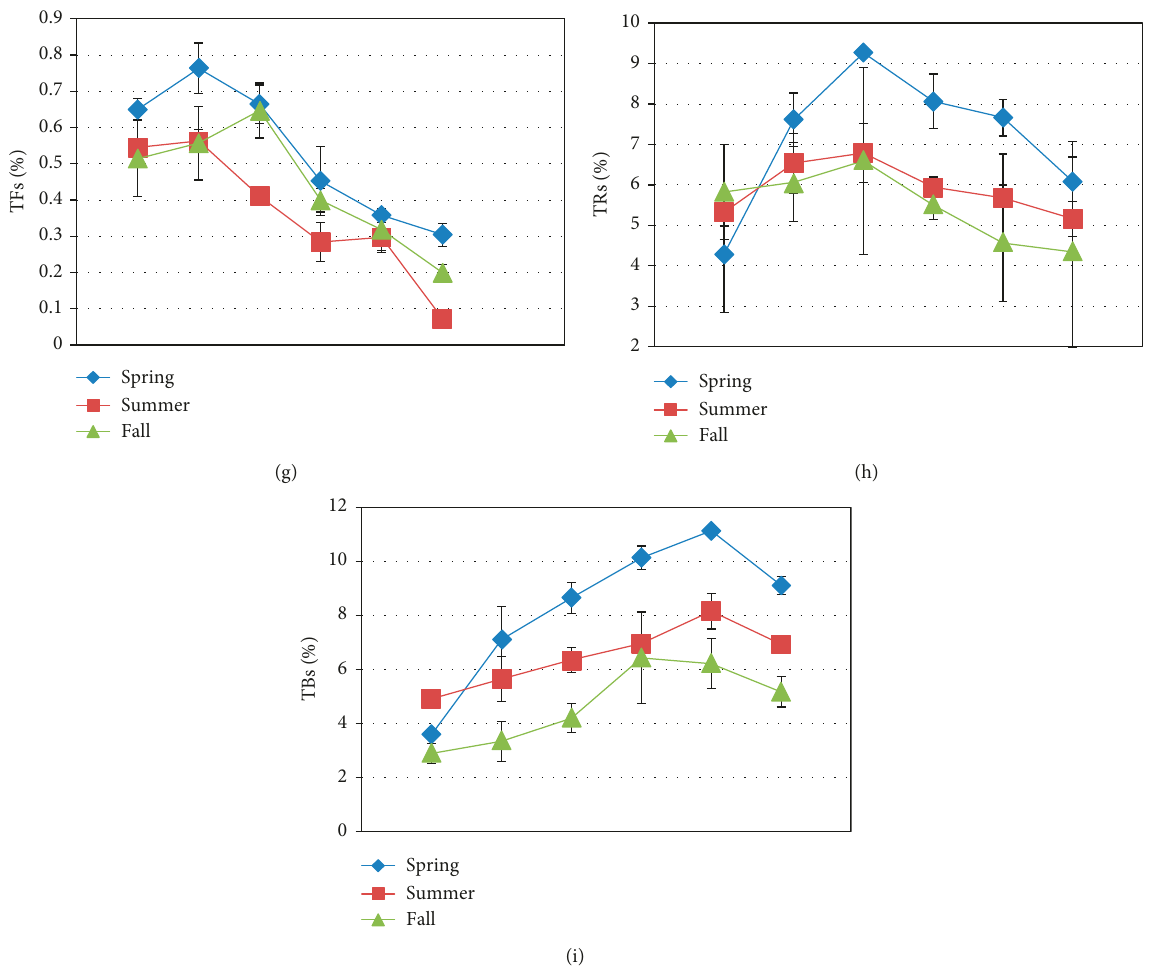
Figure 3: Theaflavins (TFs), thearubigins (TRs), and theabrownins (TBs) in fresh leaf cultivars during fermentation (a–c) different varieties; (d–f) different regions; (g–i) different